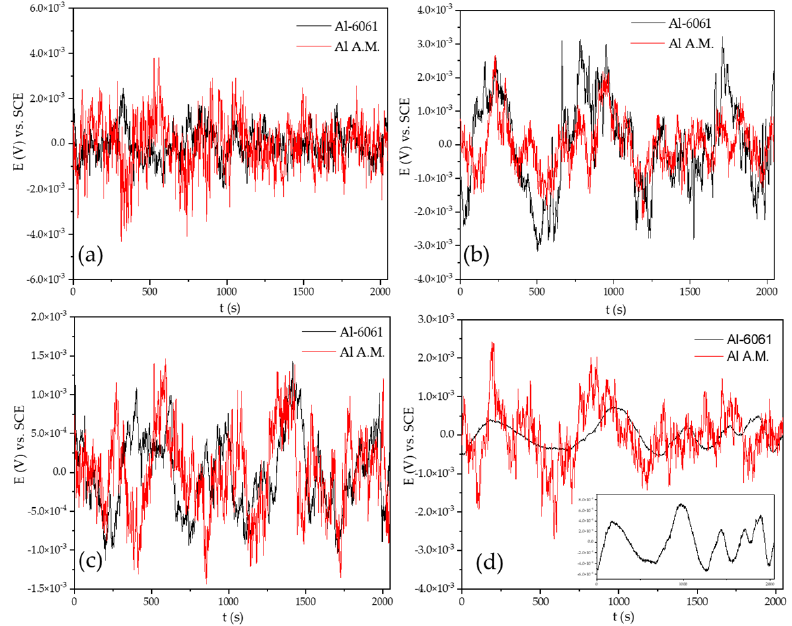
Figure 4. Time series electrochemical potential noise (EPN) data in NaCl solution. ( a ) 0 h, ( b ) 24 h, ( c ) 48 h, and ( d ) 120 h.